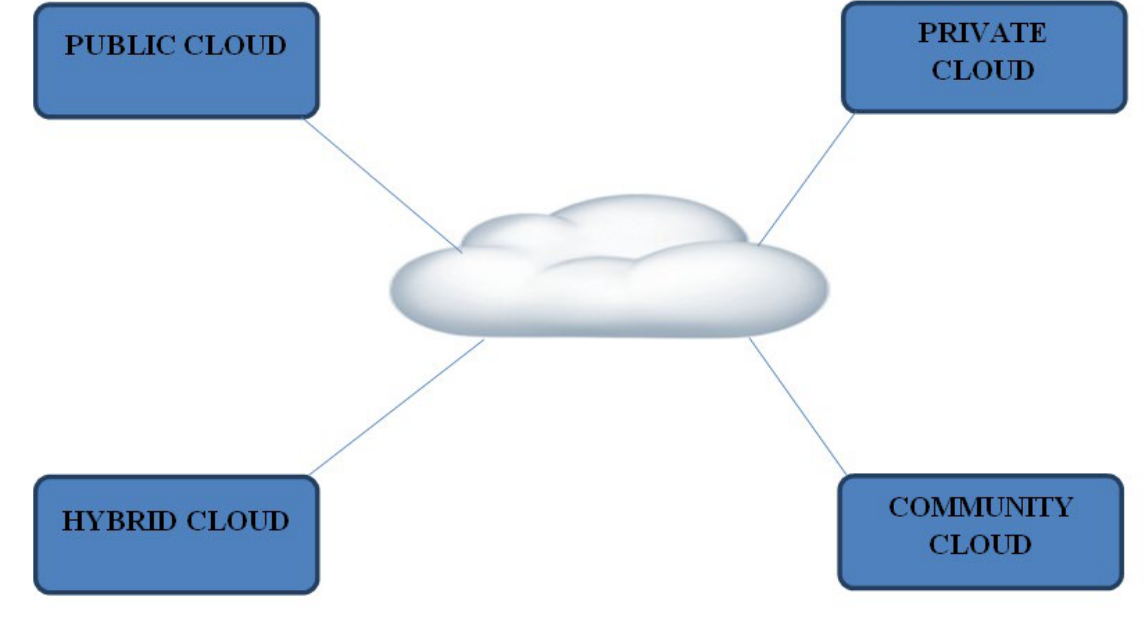
Figure 2: Common types of cloud deployment